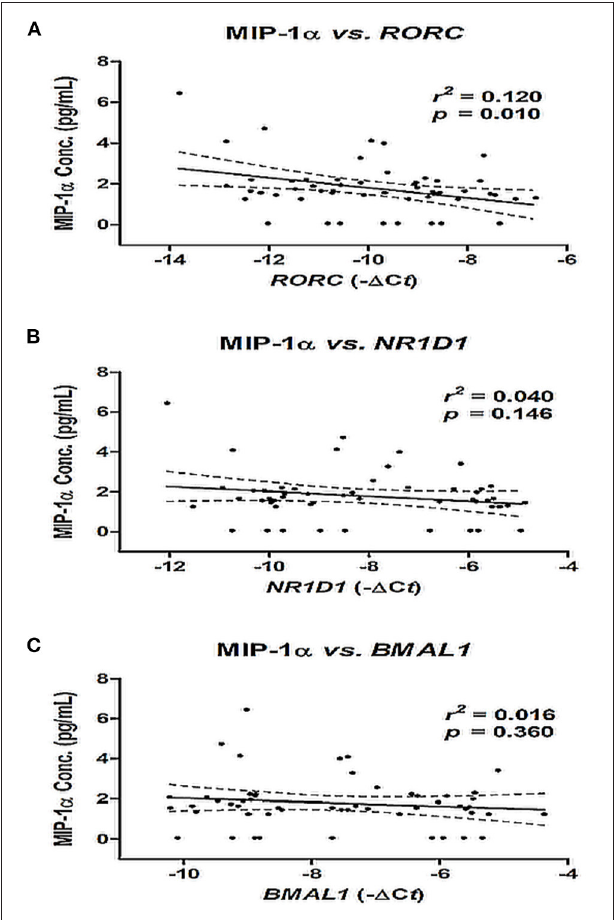
FIGURE 3 | Correlation between MIP-1 α level and mRNA expression of NR1D1 (A) , RORC (B) , and BMAL1 (C) in patients with AF. The correlation was assessed by bivariate correlation analysis. The r 2 and p -values indicate the correlation between the MIP-1 α level and the mRNA expression of RORC , NR1D1, and BMAL1 genes (expressed as – 1 Ct value). MIP-1 α , macrophage inflammatory protein-1 alpha.